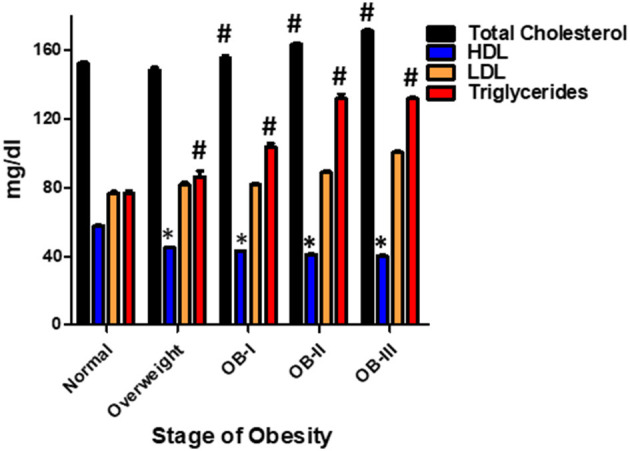
Lipid profile based on stage of obesity. Values are presented as mean ± SEM with One-Way ANOVA-test as appropriate (#p < 0.001 for total cholesterol, triglycerides; *p < 0.05 for HDL compared to normal weight group).